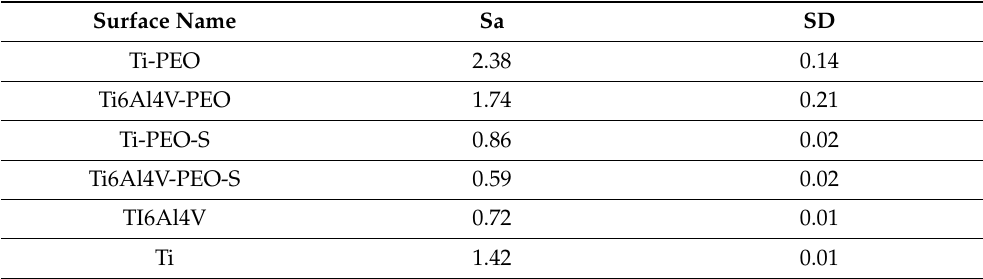
Table 2. Mean values of surface roughness (Sa) for each examined surface in μ m.